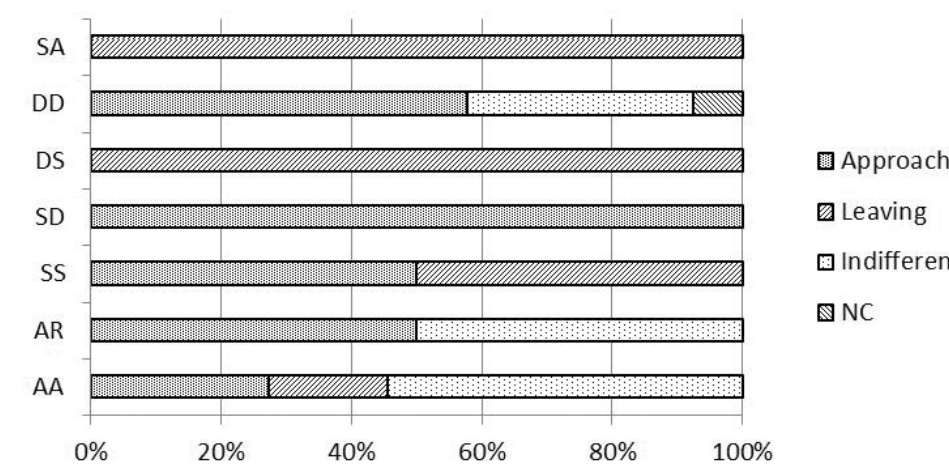
Figure 9. Cetacean responses within the 500 m MZ, according with classification on power changing in Table 1.